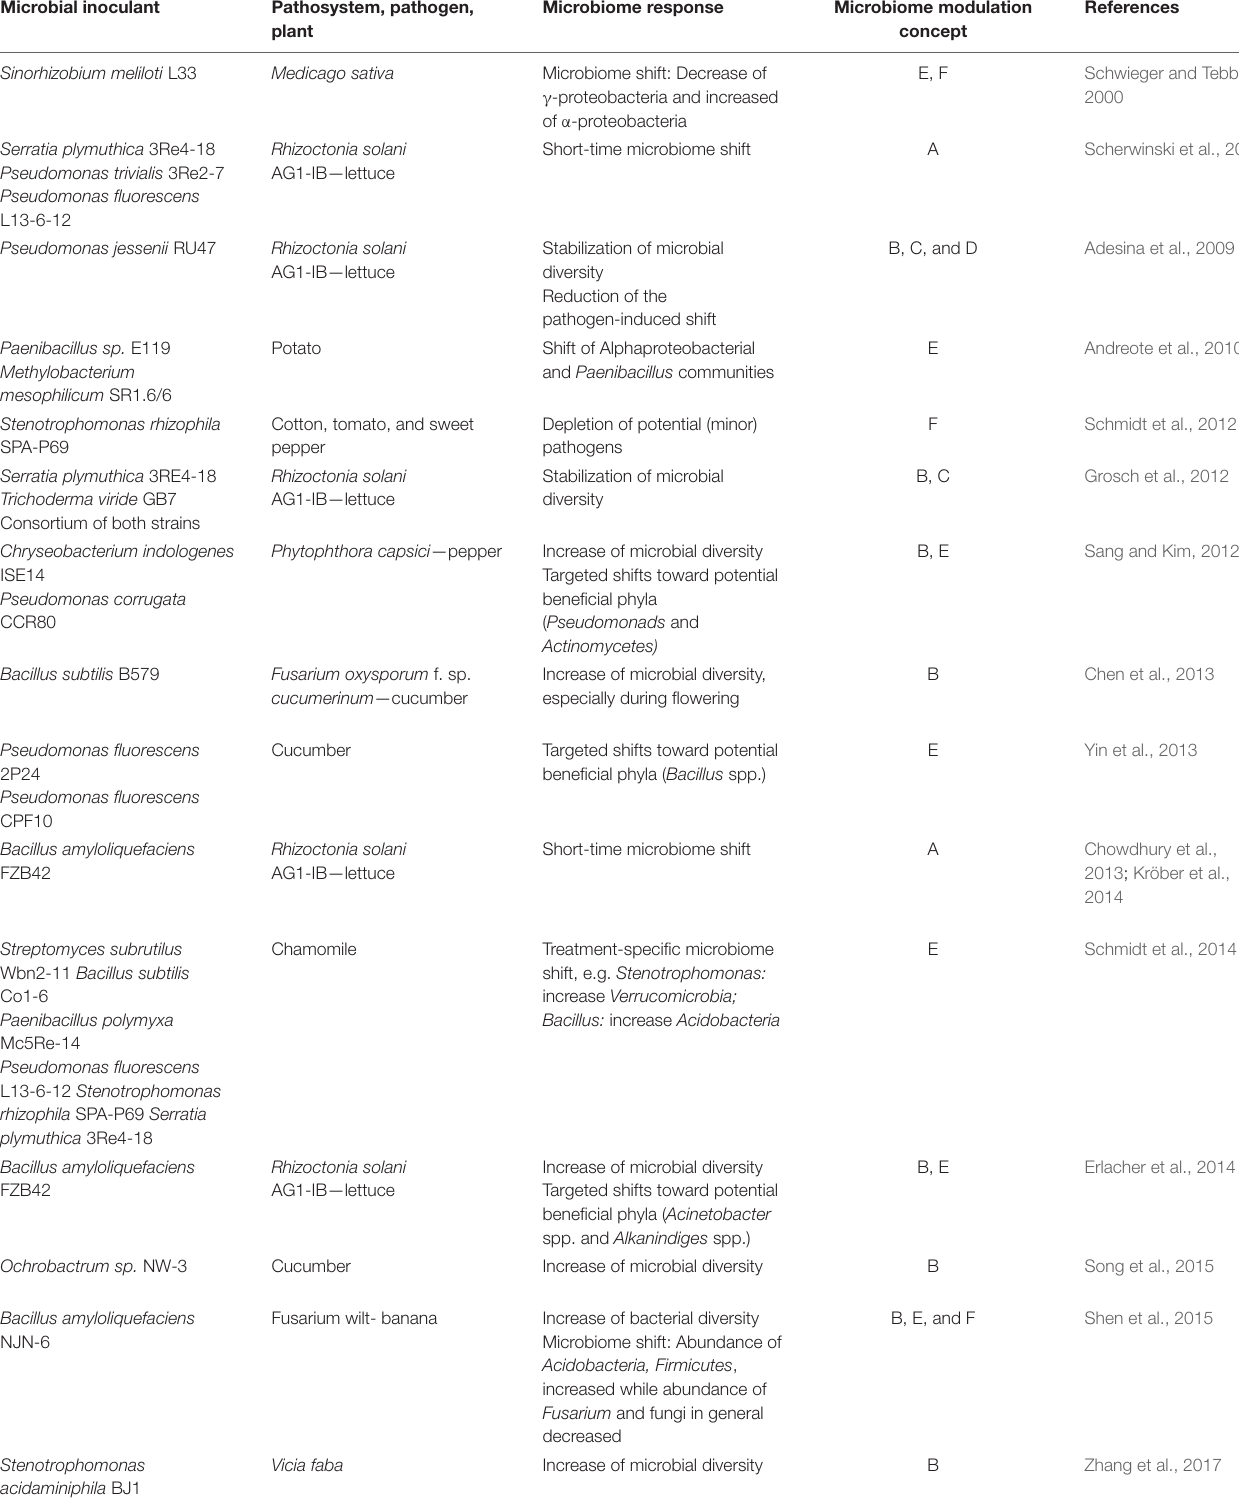
TABLE 1 | Microbial modulators and their influence on the plant